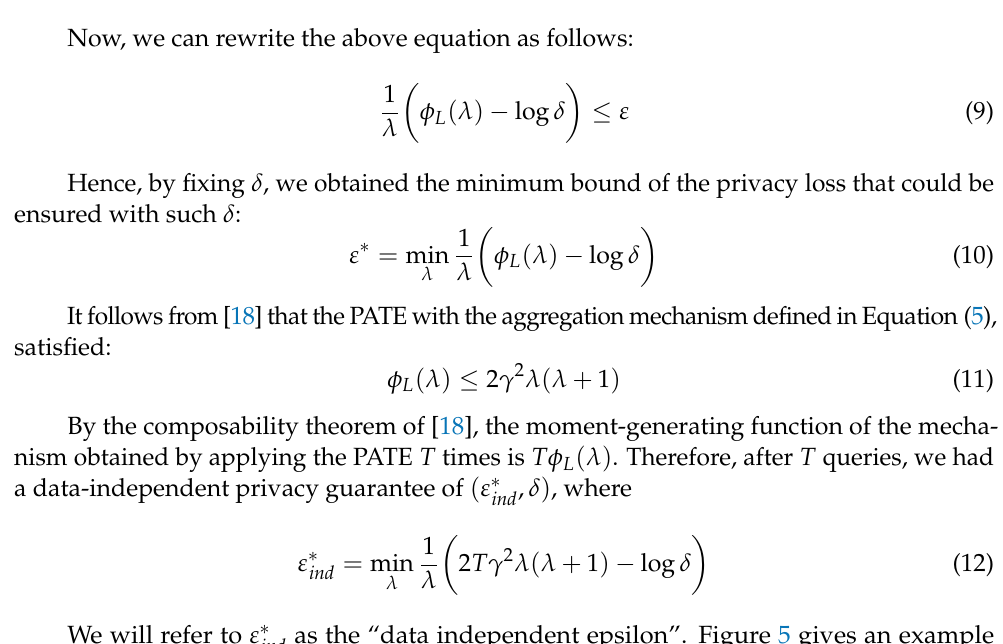
Figure 5. Graph of 2 T γ 2 λ ( λ + 1 ) − log δ . Data independent epsilon is ε ∗